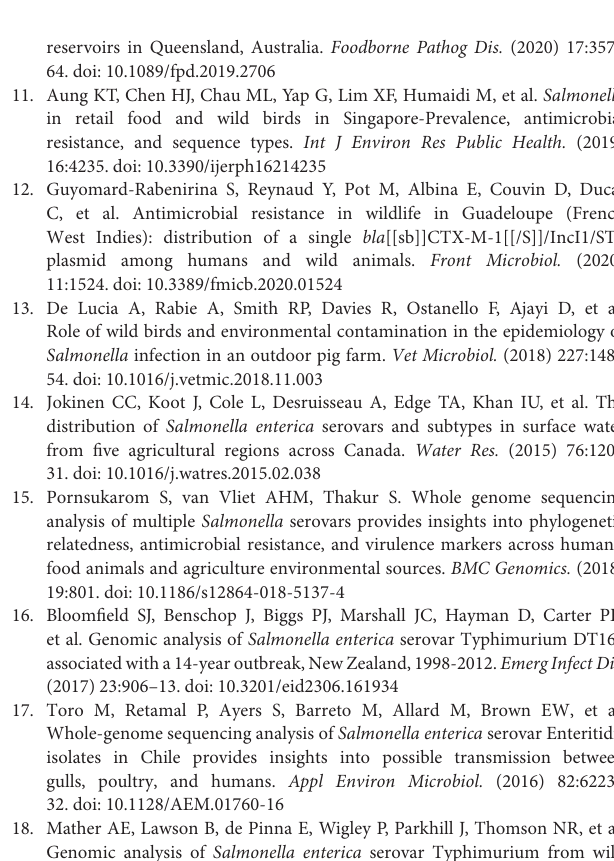
Supplementary Table 2 | Distribution of Salmonella enterica legacy multi-locus sequence types for isolates obtained from raccoons, humans, livestock, and environmental sources in southern Ontario, Canada 2011–2013 (n = 608). Supplementary Table 3 | Test sensitivity and specificity for in silico identification of acquired antimicrobial resistance genes in Salmonella enterica isolates from raccoons, humans, livestock, and environmental sources in southern Ontario, Canada 2011–2013 (n =